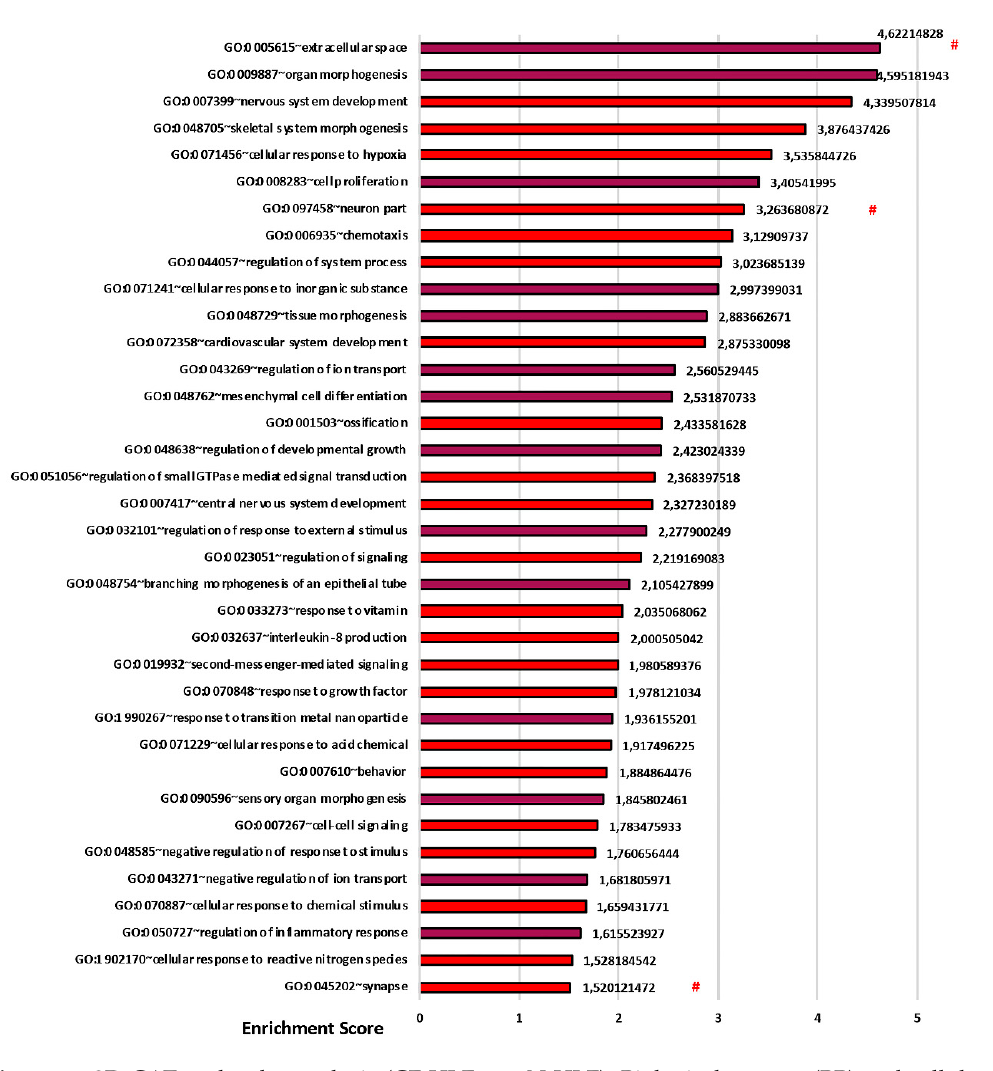
Figure 5. 3D CAT molecular analysis (CF-HLF vs. N-HLF). Biological process (BP) and cellular component (CC) significant terms in which the DEG (differentially expressed genes) induced into the 3D dataset are mainly enriched (GSE141536). The threshold of induction plotted is logFC > 2 (487 DEG). # are CC terms. Dark Red terms are the mainly interested induced terms found in our study. Table 4. Up-regulated genes from the 3D dataset (CF-HLF vs. N-HLF). Gene symbol